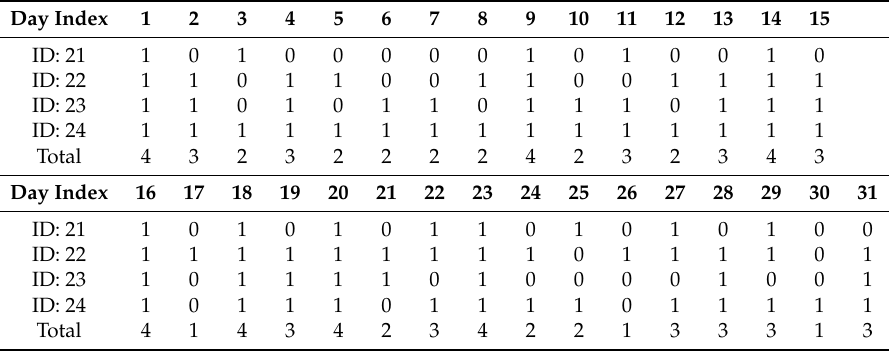
Table 1. Daily egg production records for the individual hens.